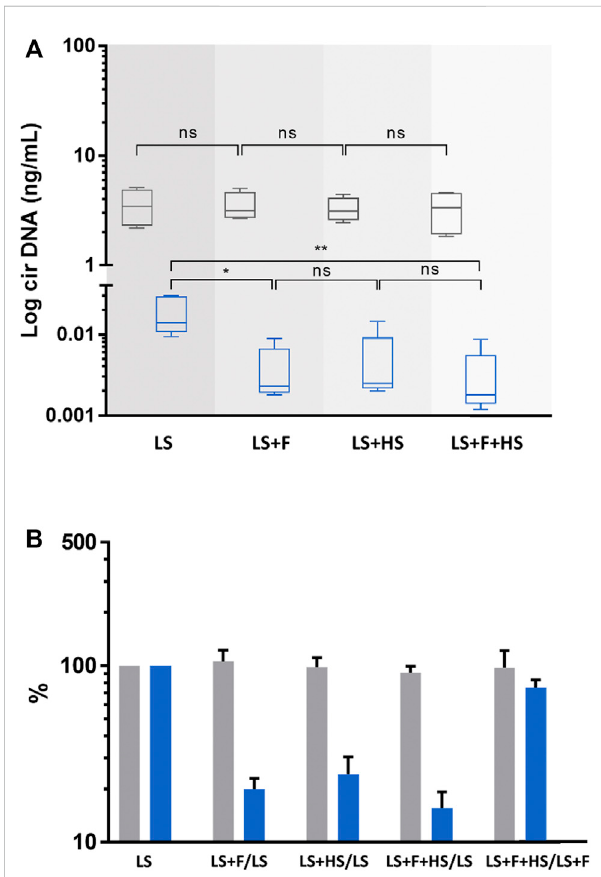
FIGURE 3 Comparison of the concentrations and variations of circulating nuclear (cir-nDNA, grey) and mitochondrial DNA (cir-mtDNA, blue) from 5 healthy individuals, depending on the physical process applied. The preparation protocol used was without platelet activation (PPw/oPA, (A,B) . The physical procedures applied were low-speed centrifugation (LS), fi ltration (F), and high-speed centrifugation (HS). Samples were either treated with LS only or with LS combined either with F (LS+F) or with HS (LS+HS). The respective variation of the cirDNA concentration in each group was obtained comparing each combination with LS only, used as a reference. Results are presented asboxplots (A) andhistograms (B) .ns,non-statisticallysigni fi cant;* p < 0.05, ** p < 0.01; *** p <